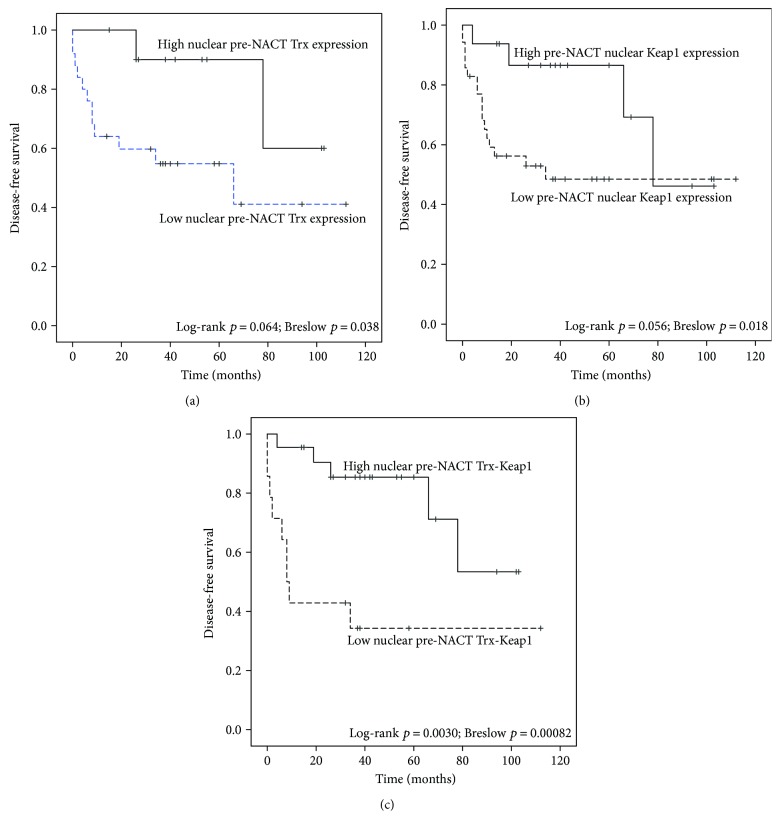
Kaplan-Meier curves comparing preneoadjuvant chemotherapy (NACT) expression of Trx (a) and Keap1 (b). Cut-offs for low and high expression have been generated with ROC analysis. In part (c), cases with both low nuclear pre-NACT Keap1 and low nuclear pre-NACT Keap1 have been set against other patients. Crosses indicate censored cases.